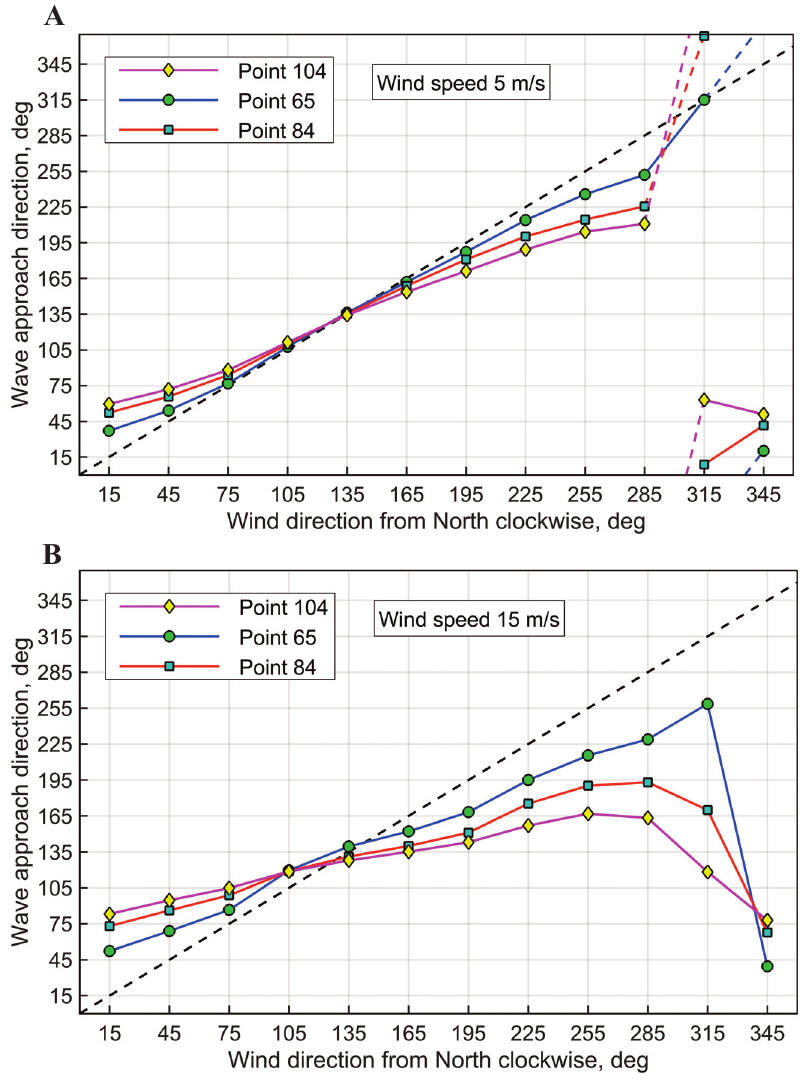
Fig. 7. Comparison of the wind direction and the mean direction of simulated wave propagation for wind speeds of 5 m/s (A) and 15 m/s (B) in saturated wave fields to the south-east of Ruhnu (point 65), on the fairway to the Port of Ringsu (point 84), and at the entrance to the Port of Ringsu (point 104). The locations of grid points are indicated in Fig.